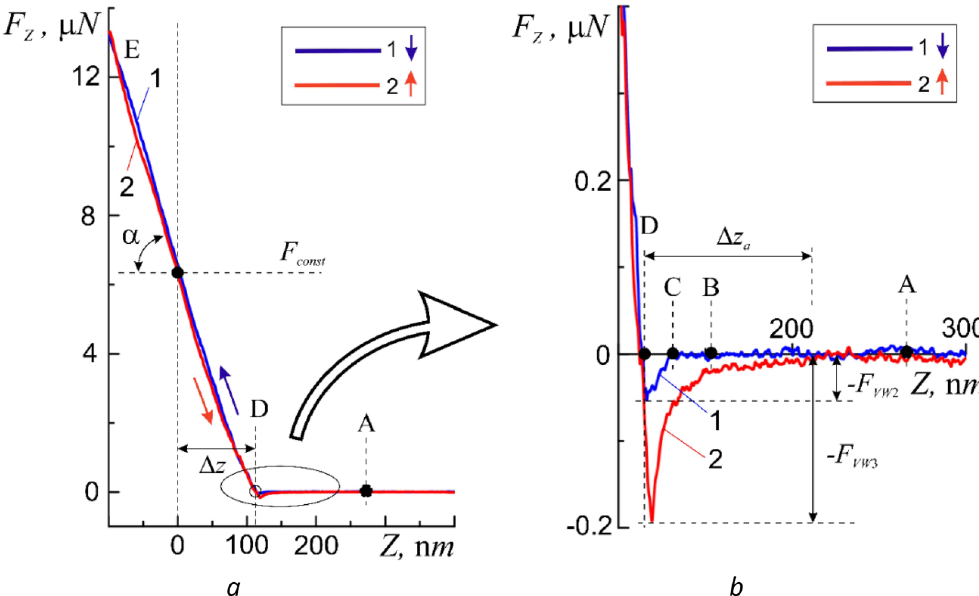
Figure 4. Approach 1 and withdrawal 2 curves obtained on the membrane surface of a human buccal epithelium cell at one point for the following values of the initial force action F II ,const 1 = 6.2 μN ( a ), and a more detailed image of the same curves in the adsorption layer region ( b